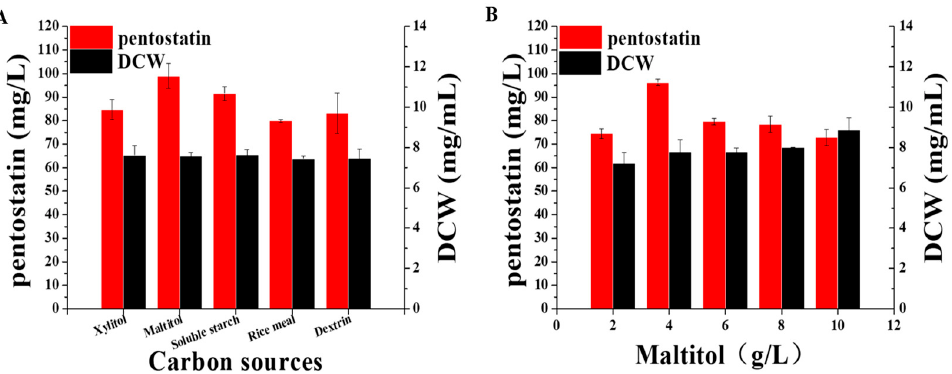
Figure 6. Effect of different carbon sources ( A ) and maltitol concentrations ( B ) on pentostatin Figure 6. E ff ect of di ff erent carbon sources ( A ) and maltitol concentrations ( B ) on pentostatin pro- production and biomass in Actinomadura sp. duction and biomass in Actinomadura sp. S-15.